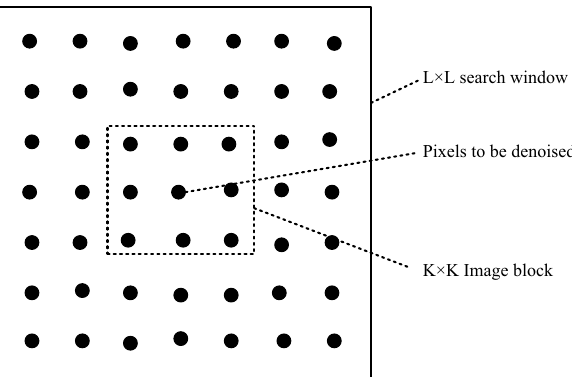
Figure 2: Image similar feature search model.